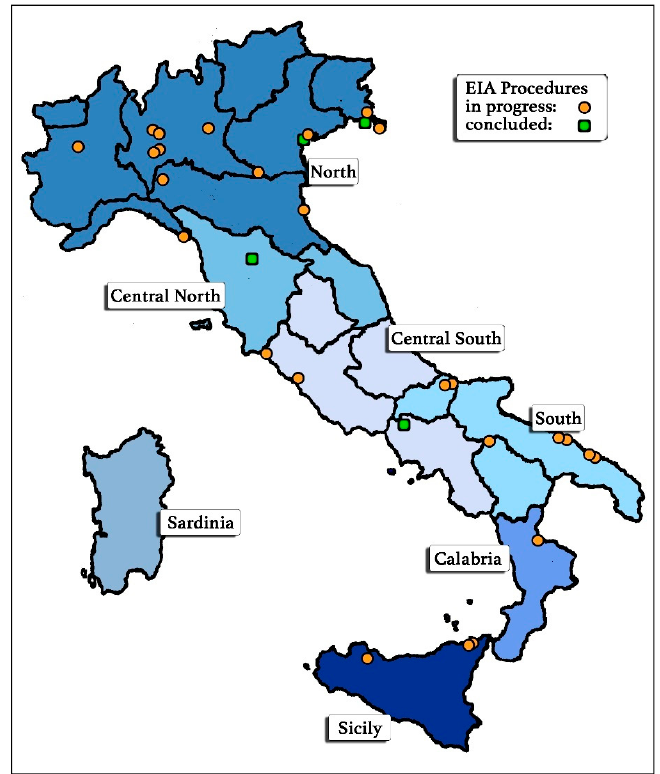
Figure 9. State of the art of permitting procedure for capacity market installations [37].